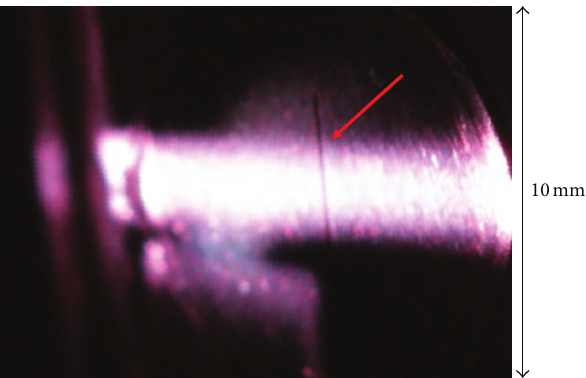
Figure 2: Photograph of the entrance of the optical cable with the image of the plasma jet. Red arrow shows the entrance of the optical fibre system with height of 4mm.